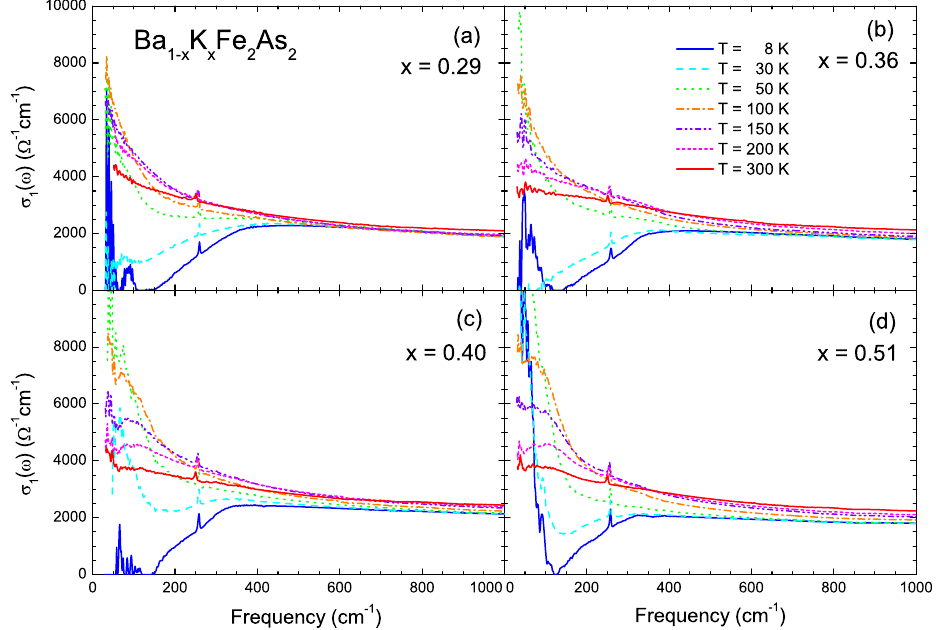
Figure 2. (Color online) Optical conductivity spectra of Ba 1 levels and at various selected temperatures between 8 and 300 K; ( a ) x x =